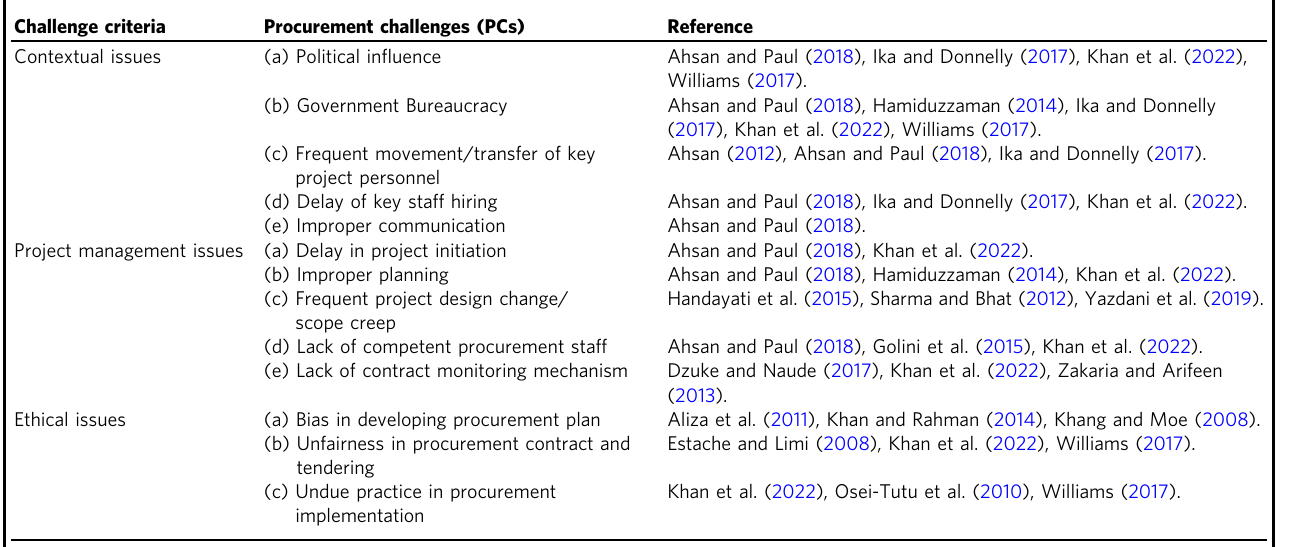
Fig. 2 Theory of change. Application of the theory of change within the existing project procurement management practices. Table 1 Public-sector agriculture project supply-chain challenge framework. Challenge